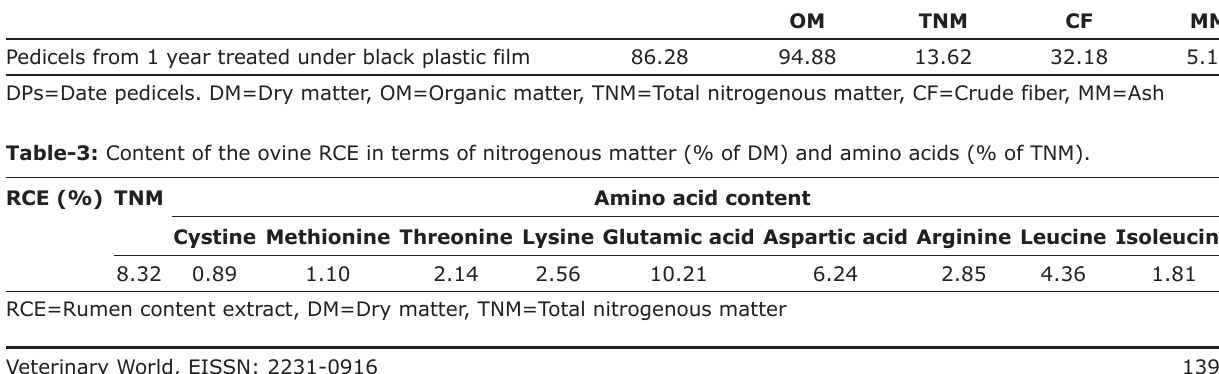
Table-2: Chemical composition of DPs[9]. Designation